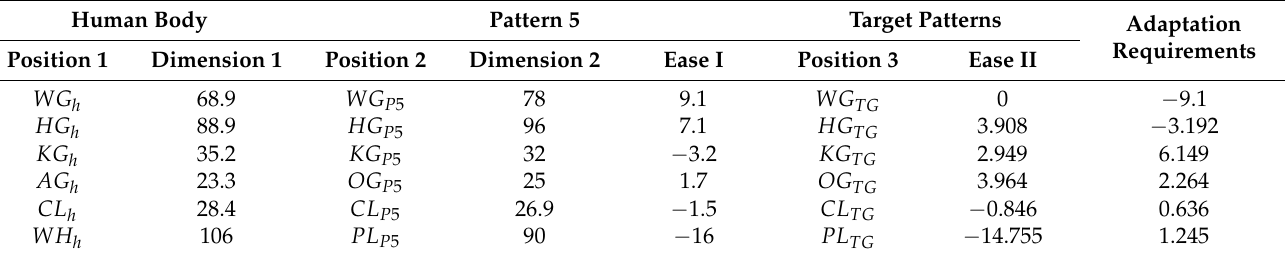
Table 9. The adaptation requirements of the pattern (unit: